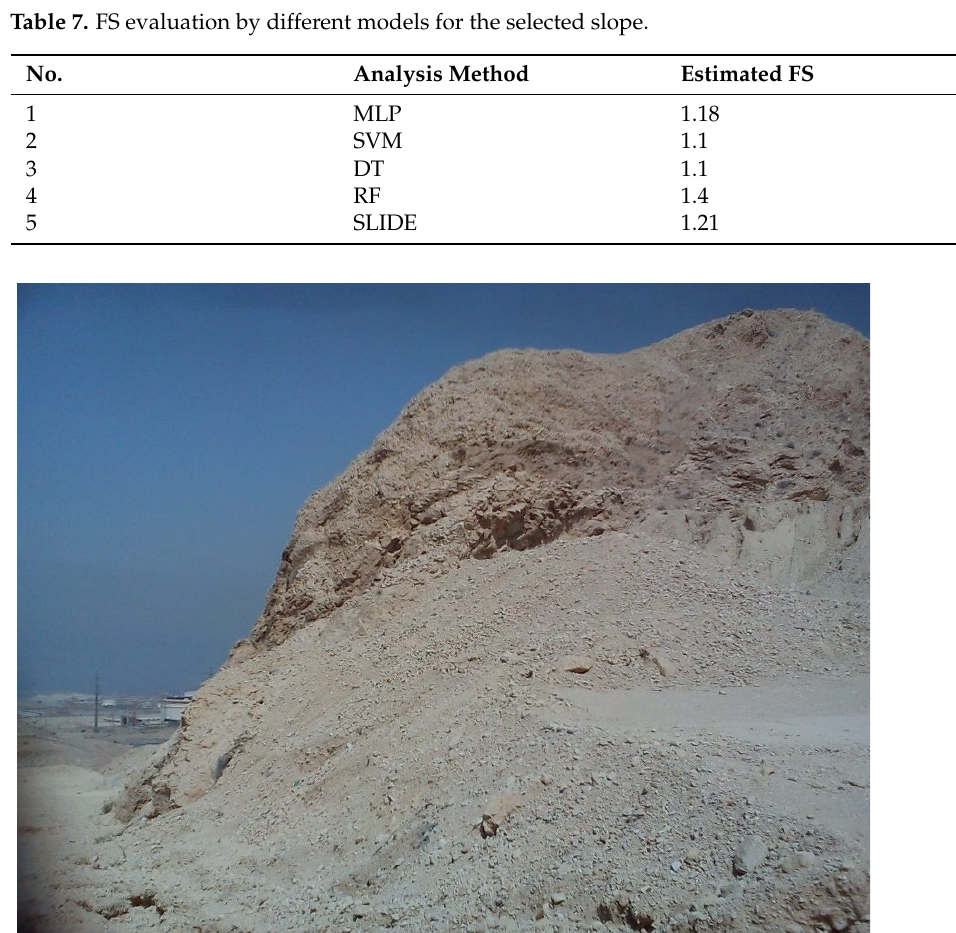
Figure 5. A view of the selected slope in the South Pars region.